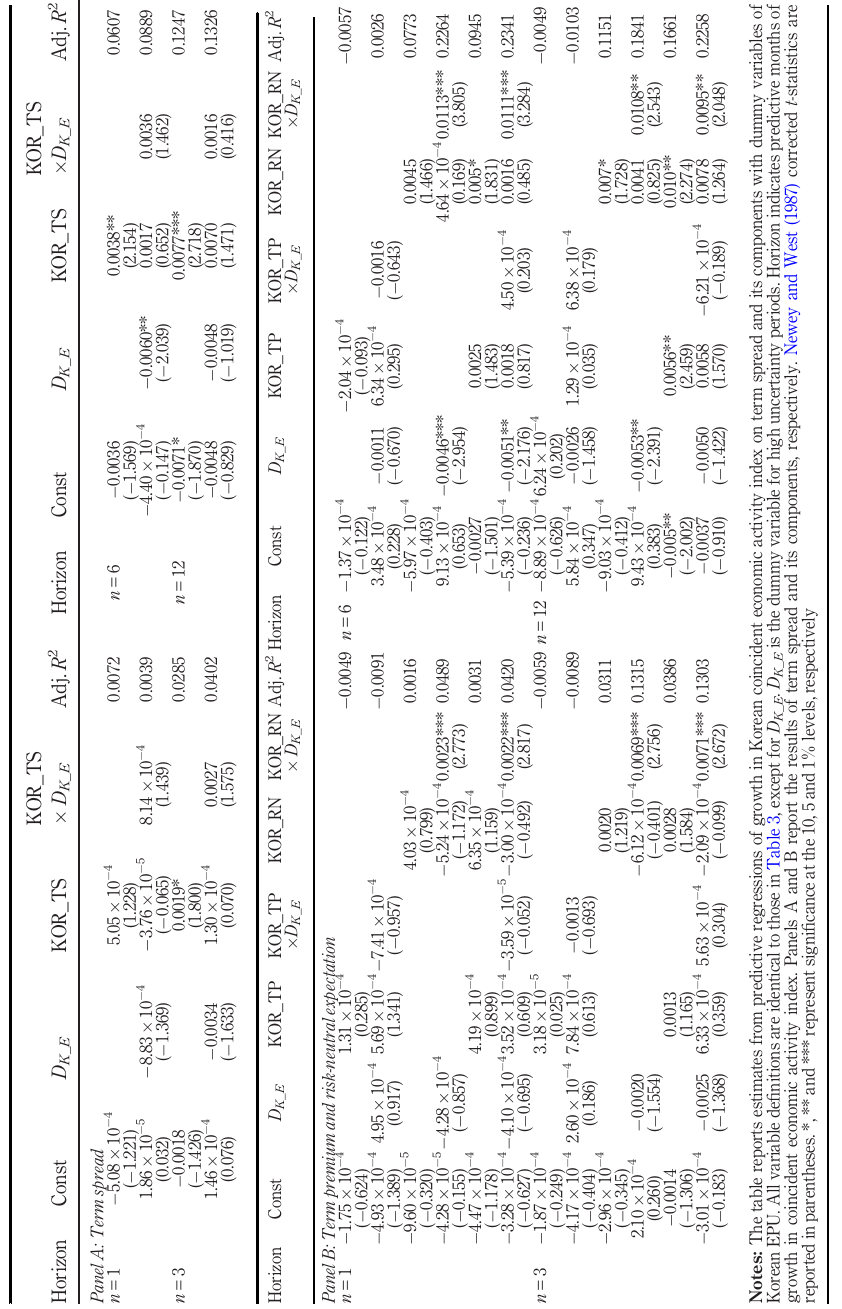
spread and its components with uncertainty in Korean economy: Coincident economic activity